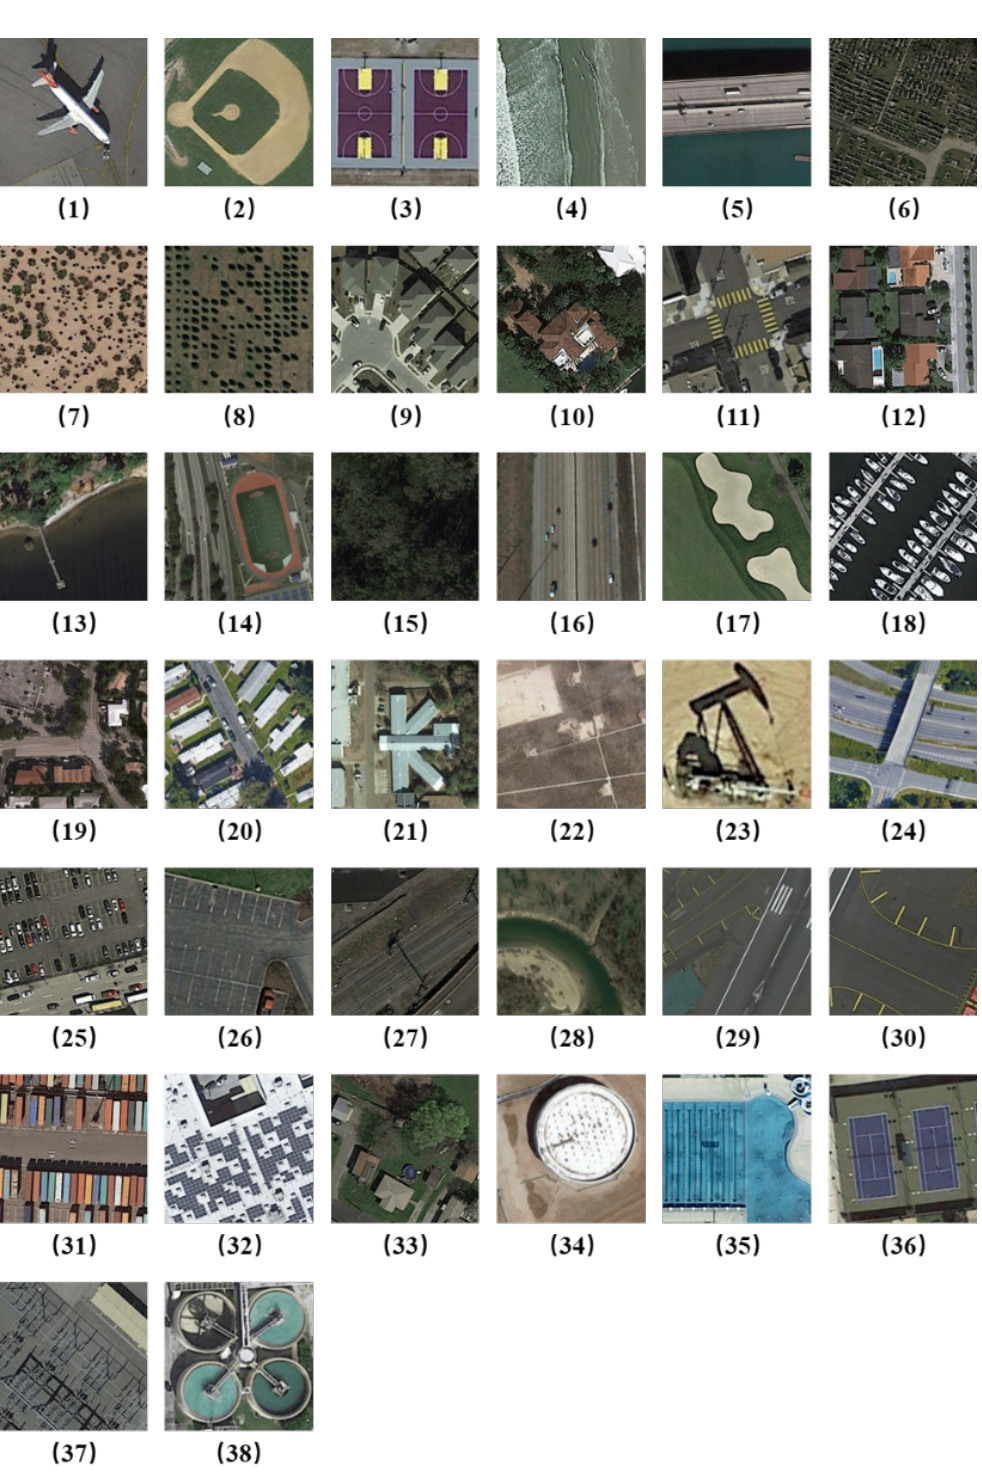
Figure 9. Example images of the PatternNet dataset: ( 1 ) airplane, ( 2 ) baseball field, ( 3 )